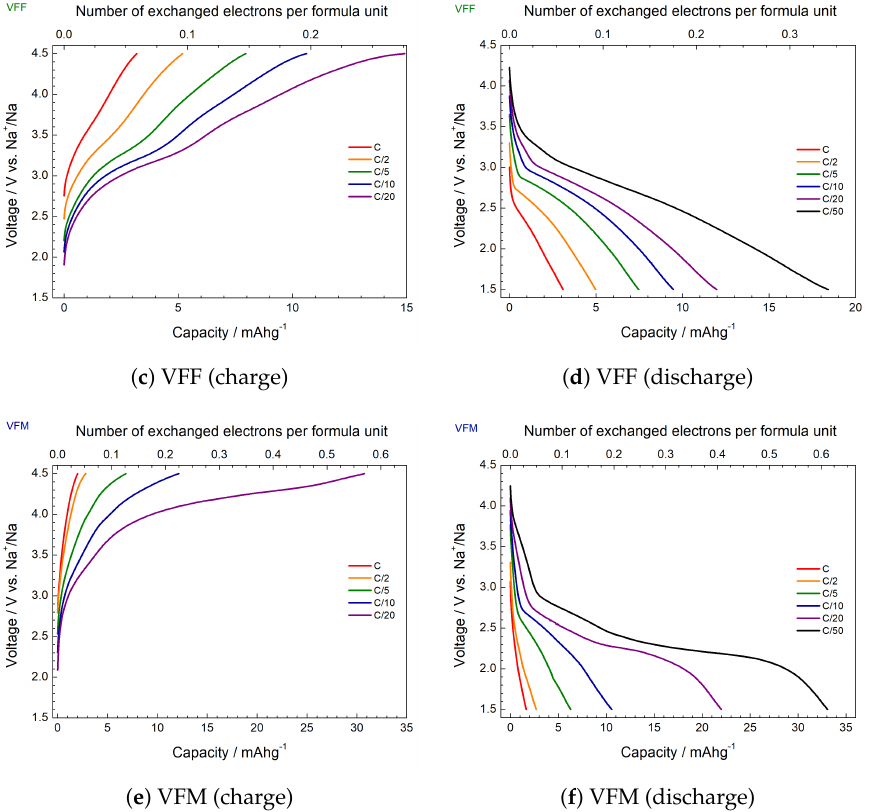
Figure 4. Typical charge and discharge curves for the FFF ( a , b ), VFF ( c , d ), and VFM ( e , f ) cathode materials taken at various current ranges from C/50 to C.